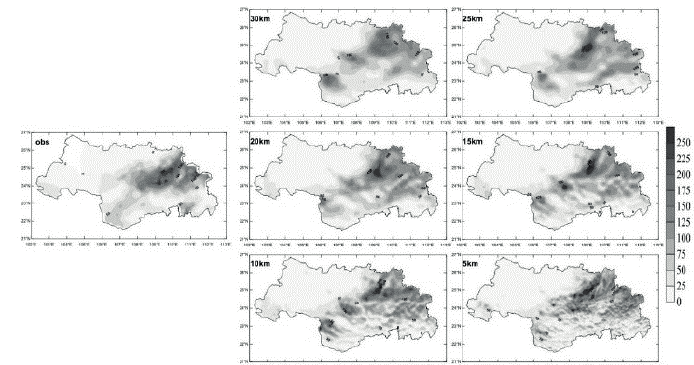
Fig. 2 Comparison of observed and simulated precipitation distribution at different horizontal resolution for Storm 3